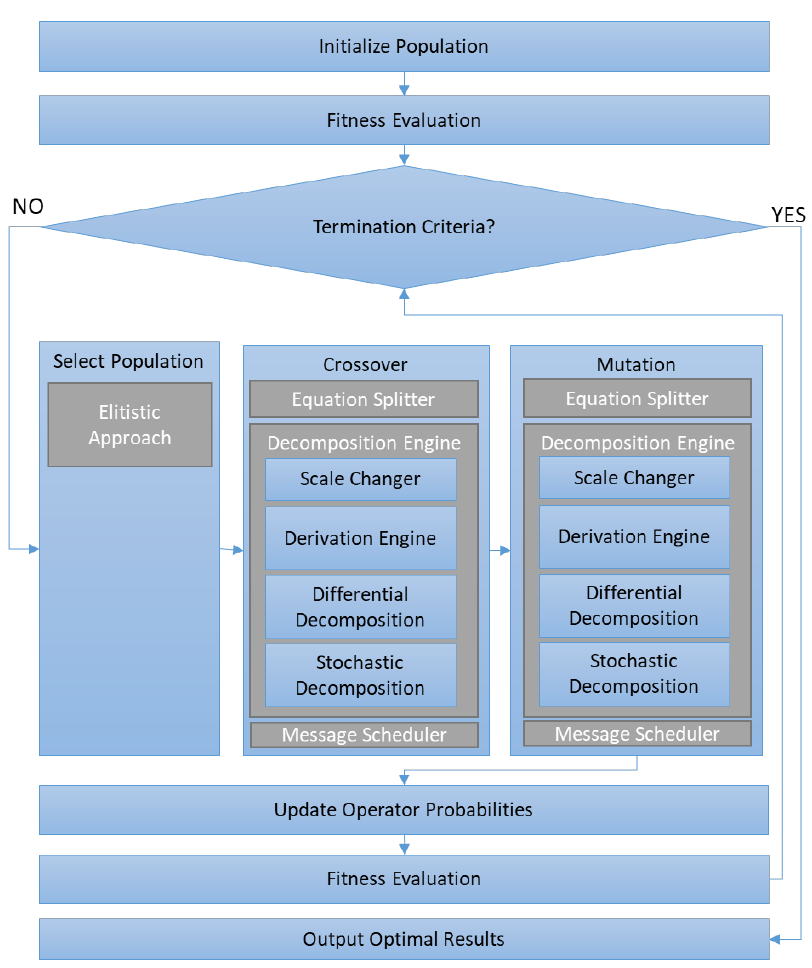
Figure 5. Diagram flow of Genetic Algorithm with Evolution Control.